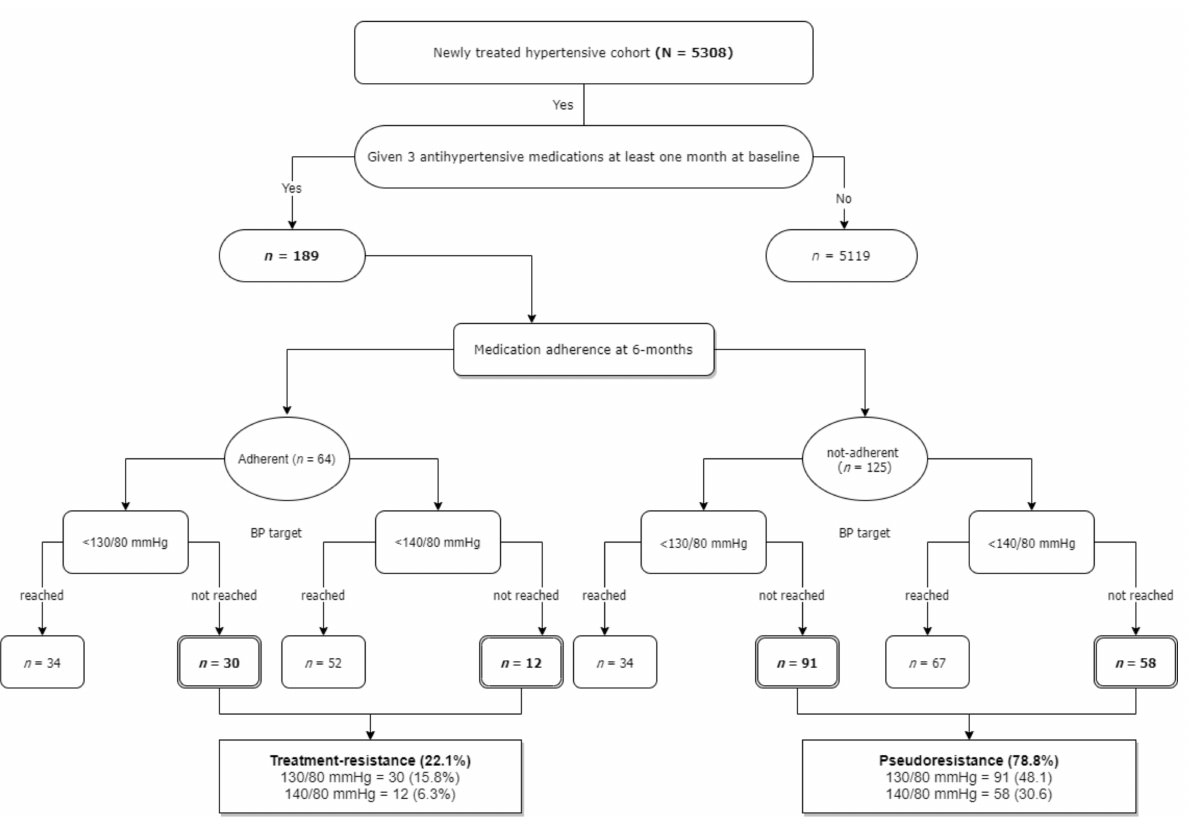
Figure 4. Flow chart of study population taking three or more medications for at least 1 month and prevalence of treatment- resistant